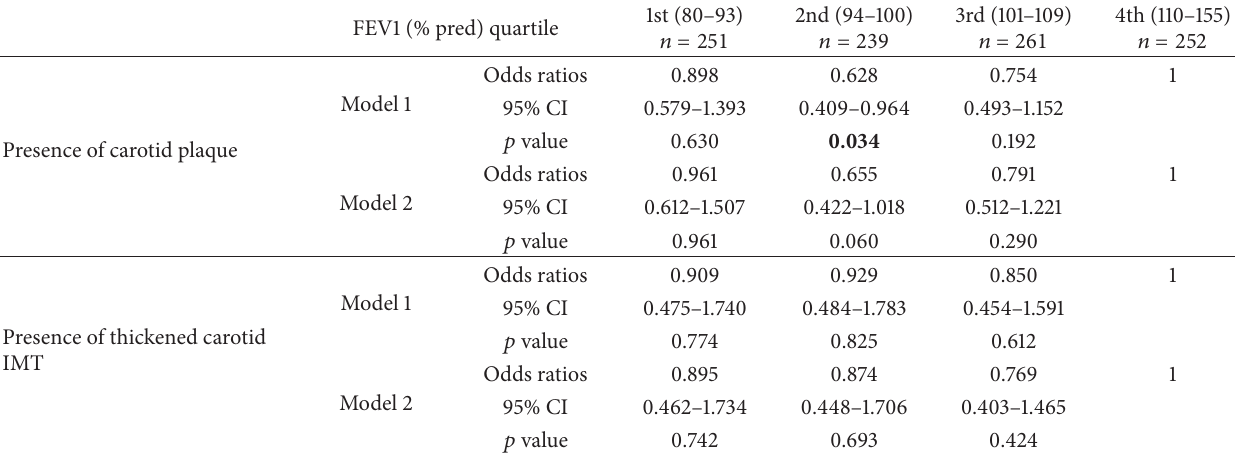
Table 4: The risk of presence of carotid plaque and thickened carotid IMT by FEV1 (% pred)